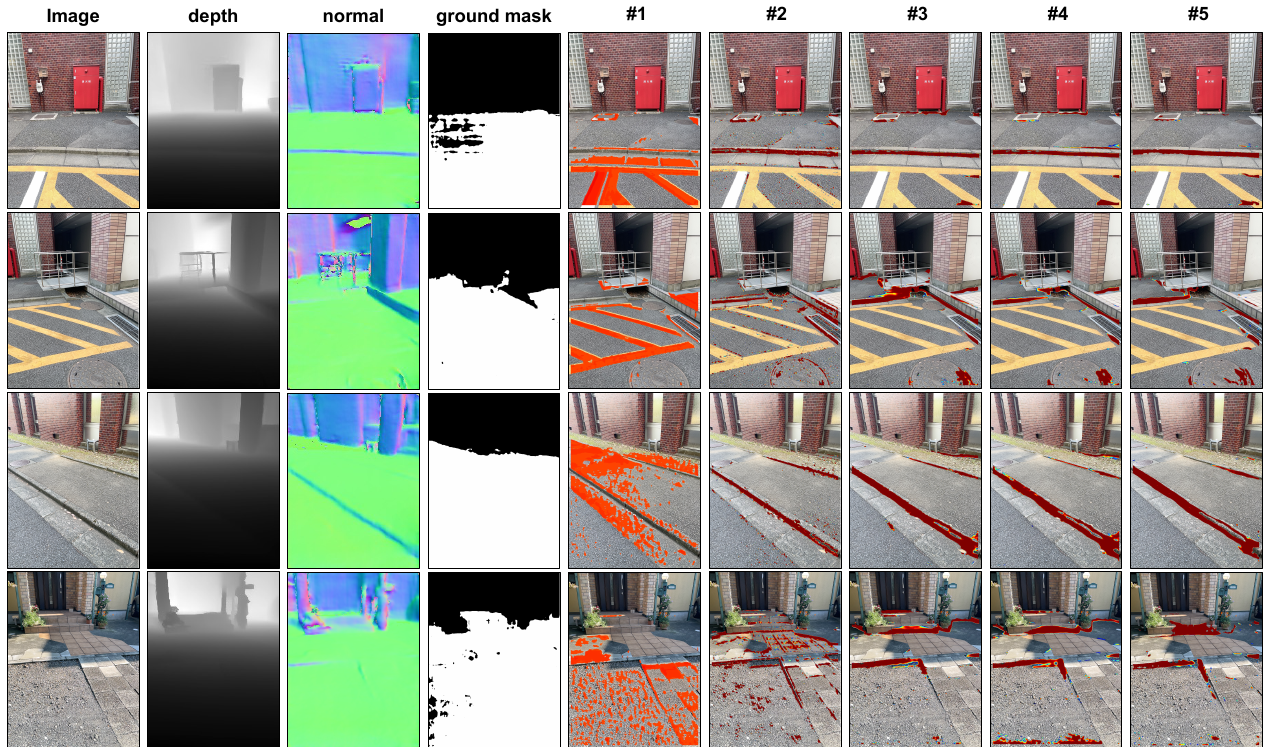
Figure 11. Results with a patch size of 32 × 32 as input. The numbers correspond to the numbers in Table 1.